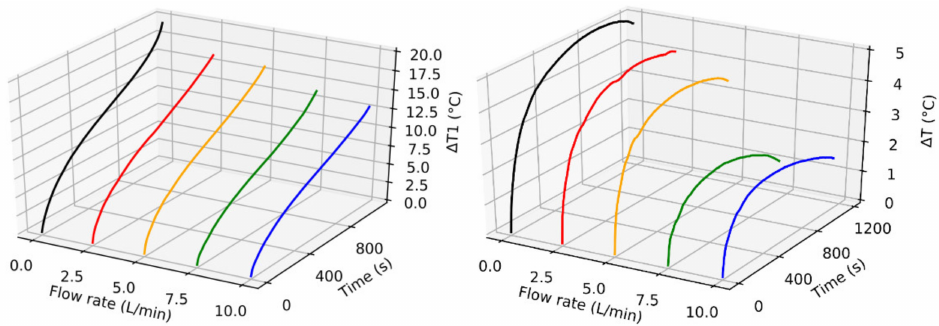
Figure 10. The maximum temperature rise (T max ) and temperature gradient ( ∆ T) for the cooling system with various inlet flow